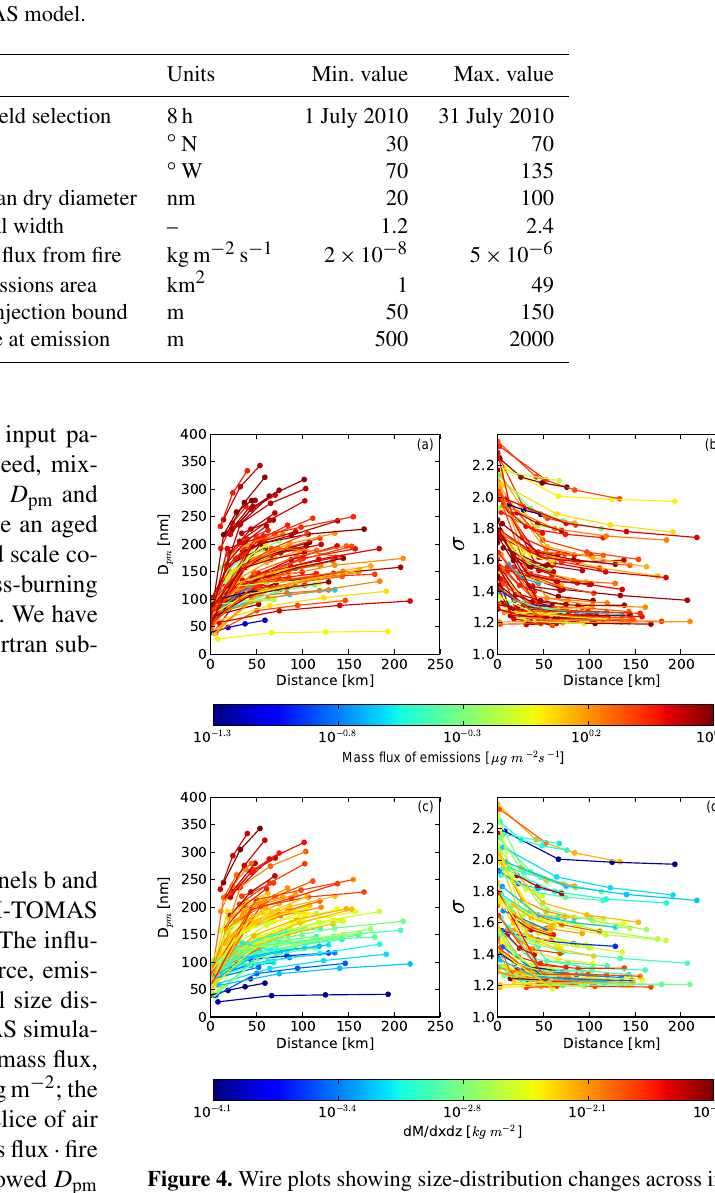
Figure 4. Wire plots showing size-distribution changes across indi- vidual SAM-TOMAS simulations colored by emission mass flux (a, b) and d M/ d x d z (c, d) for D pm (a, c) and σ (b, d) .